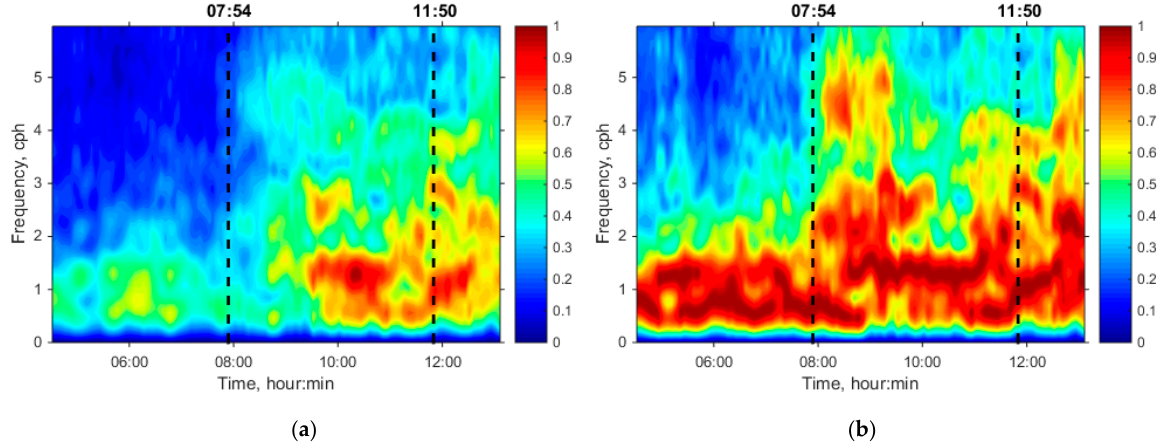
Figure 10. Experimental spectrogram of intensity fluctuations. Normalization: ( a ) on global maxi- mum during all the time period ( b ) on local maximum for each moment of time. Dashed lines denote time moments of the soliton’s passing of thorough the source position (07:54) and chain E2 (11:50).